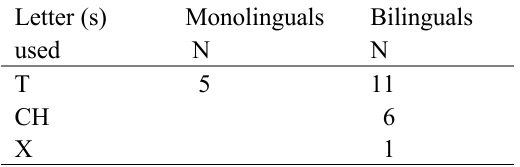
Table 7. Children’s misspellings for the phoneme / tr / in trousers Letter